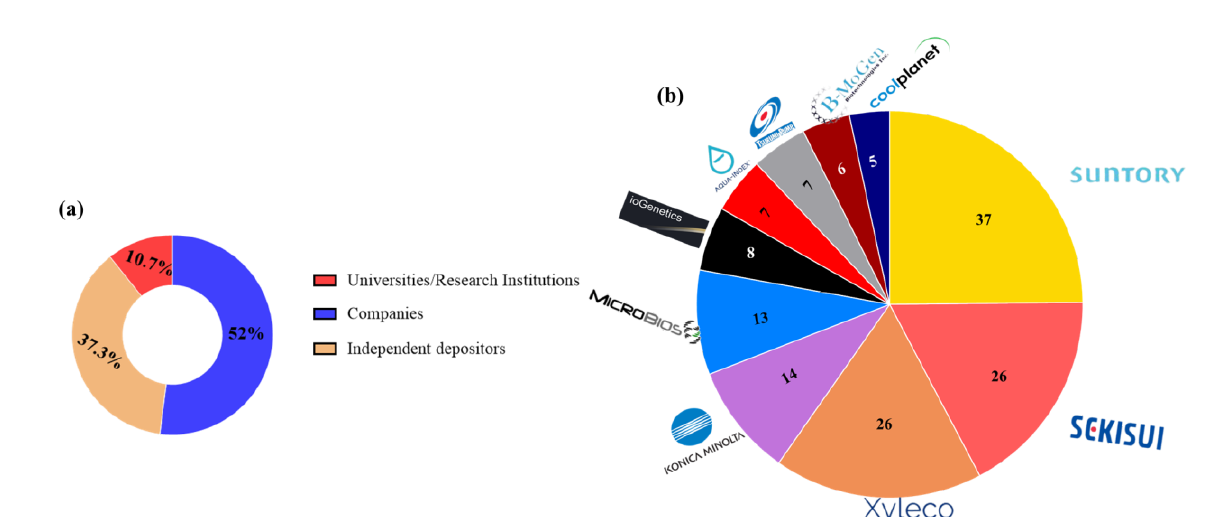
Figure 8. Distribution of patent applicants regarding the participation of family farming in the development of new food products ( a ) and top 10 companies that filed patent applications on the subject ( b ).